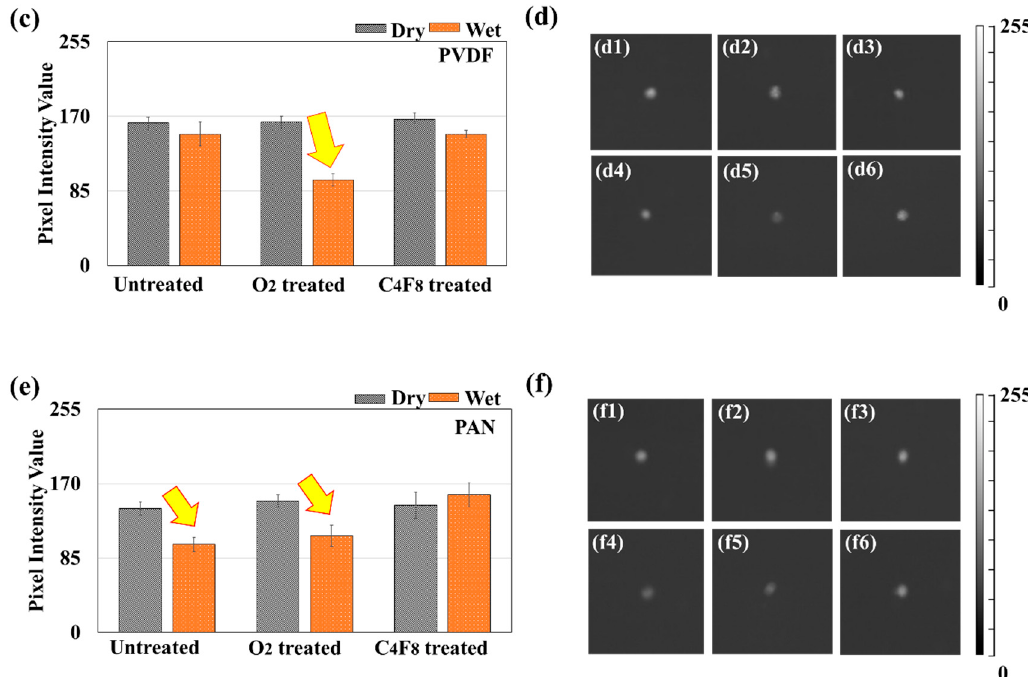
Figure 8. Mechanoluminescence intensity for ML composites with di ff erent treatments. ( a ) PIV of ML / PVDF with time in the wet state; ( b ) PIV of ML / PAN with time in the wet state; ( c ) maximum PIV of ML / PVDF in dry and wet states; ( d1–d3 ) PIV image of ML / PVDF untreated, O 2 -treated, and C 4 F 8 -treated, respectively, in a dry state; ( d4–d6 ) PIV image of ML / PVDF untreated, O 2 -treated, and C 4 F 8 -treated, respectively, in the wet state; ( e ) maximum PIV of ML / PAN in dry and wet states; ( f1–f3 ) PIV image of ML / PAN untreated, O 2 -treated, and C 4 F 8 -treated, respectively, in a dry state; ( f4–f6 ) PIV image of ML / PAN untreated, O 2 -treated, and C 4 F 8 -treated, respectively, in the wet